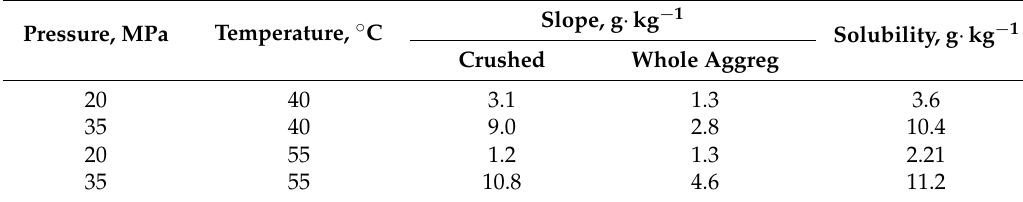
Table 1. Initial slopes of extraction curves of lipids extracted from crushed and whole aggregates of dry Chlorella vulgaris [7] compared with vegetable oil solubility in scCO 2 calculated according to del Valle et al.